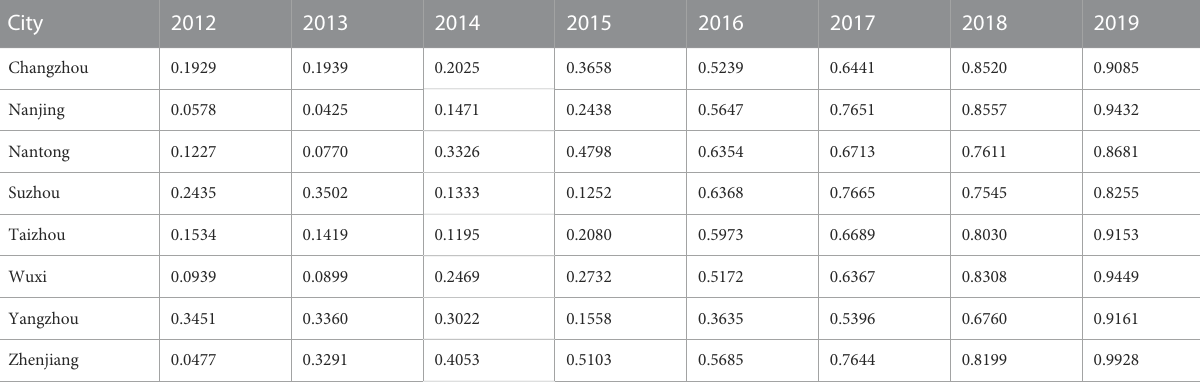
TABLE 2 Water environment carrying status index of eight cities along the Yangtze River in Jiangsu province from the city view by the projection pursuit method. City